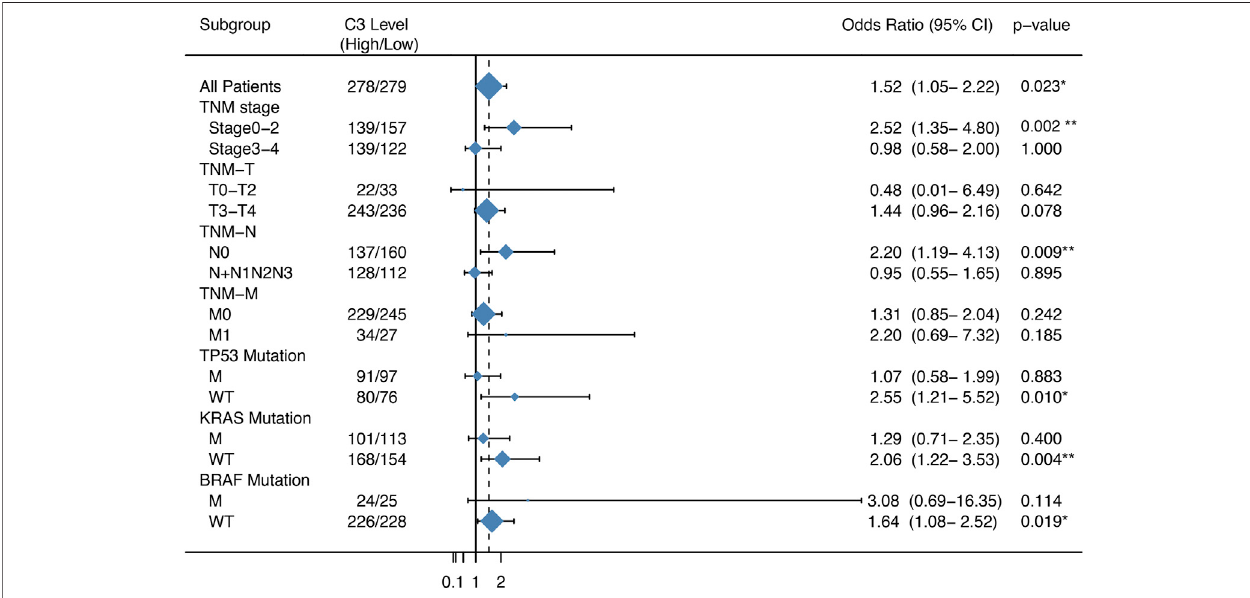
FIGURE 3 | Forest plot of the association between C3 gene expression and the recurrence risk of colorectal cancer. Samples in the GSE39582 dataset were categorized according to the median expression C3 gene. Odds ratio (OR) and 95% con fi dence interval (95% CI) were calculated to assess the risk of recurrence. M: mutation; WT: wild type. * p < 0.05, ** p <